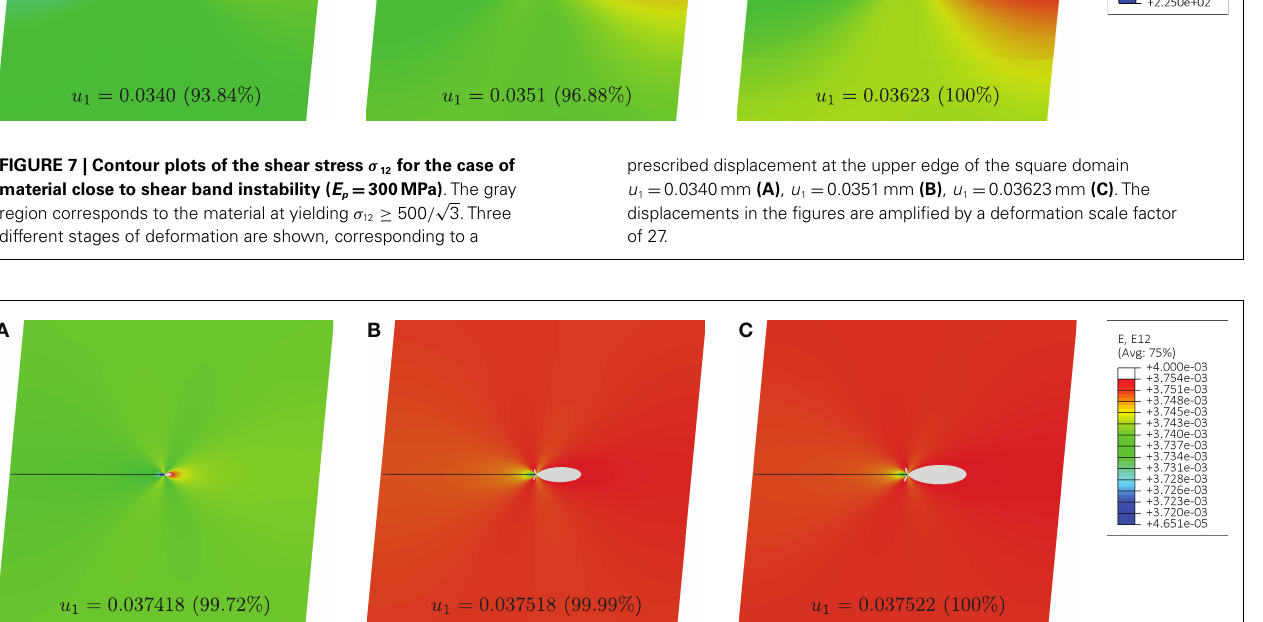
FIGURE 8 | Contour plots of the shear deformation γ 12 for the case of material far from shear band instability ( E p = 150000MPa) .Three different stages of deformation are shown, corresponding to a prescribed